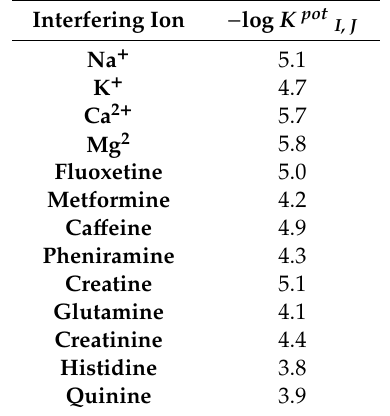
Table 2. Potentiometric selectivity coe ffi cients ( logk pot with o-nitrophenyl octyl phthalate (o-NPOE) in a 50-mM phosphate solution of pH 3.0.